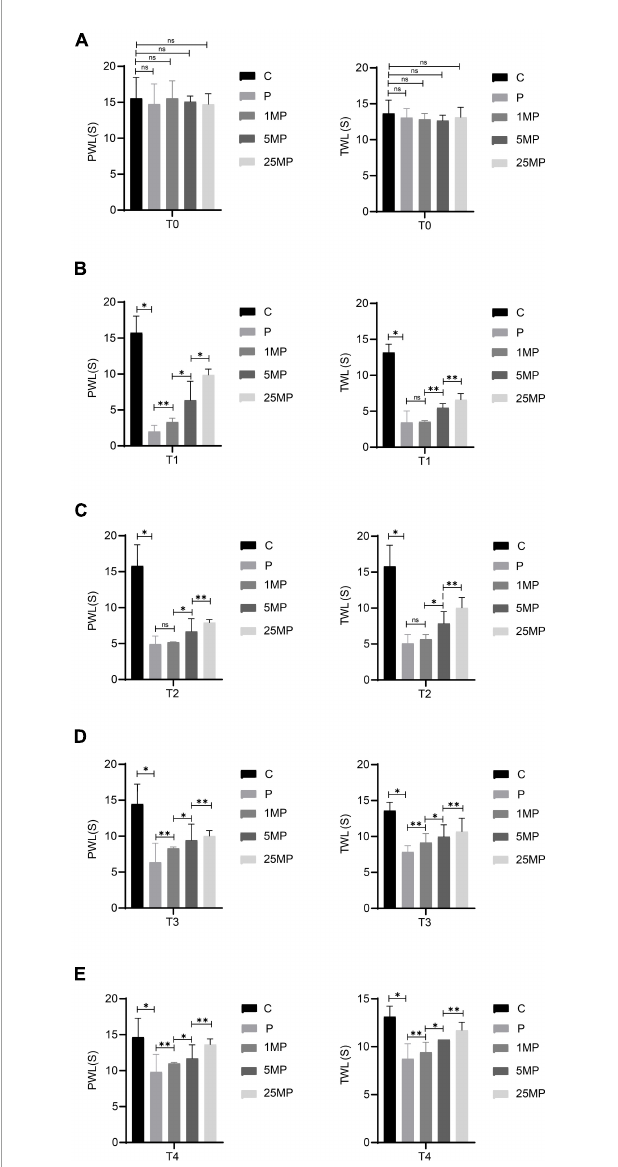
FIGURE7 Effect of intrathecal injection of motilin (MTL) on the mechanical withdrawal threshold (MWT) measured as paw withdrawal latency (PWL) and thermal foot withdrawal response latency (TWL) in the control (C) and pain model groups (P) at 24 h before operation [T0; (A) ], 2 h after the operation [T1; (B) ], 24 h after the operation [T2; (C) ], 48 h after the operation [T3; (D) ], and 72 h after the operation [T4; (E) ]. 1MP, pain with 1 µ g of MTL; 5MP, pain with 5 µ g of MTL; and 25MP, pain with 25 µ g of MTL. ns, not significant; ∗ P < 0.05, ∗∗ P <